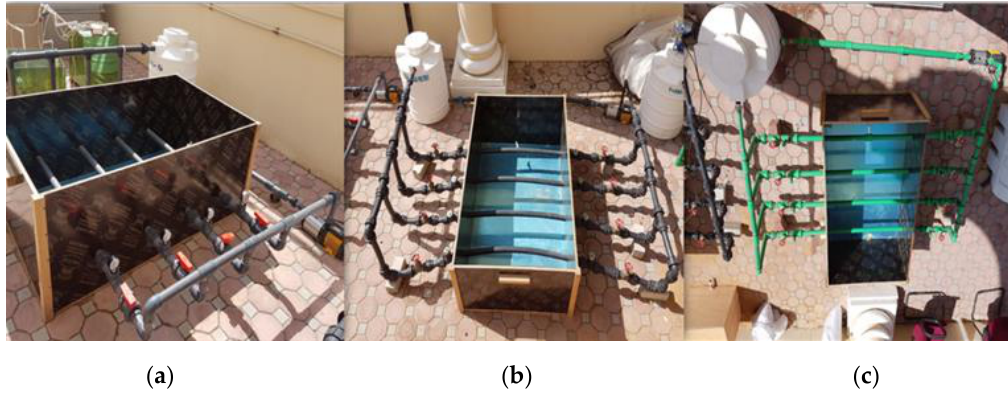
Figure 3. Setups with different types of pipe material: ( a ) PVC; ( b ) PE; and ( c ) PPR. Second, different types of leaks were induced to evaluate the ability of the NDTs on wide-ranging pipe conditions. The first pipe was undamaged, the second contained a vertical crack, the third had a hole, and last pipe consisted of a faulty joint as illustrated in Figure 4. To prevent water leaking from one pipe to seep to the adjacent pipes, the three simulated leaks were induced in different ends of the pipes. Thus, the vertical crack was induced on the left end of the second pipe (Figure 4a), the hole was drilled at the right end of the third pipe (Figure 4b), and the joint was installed at the center of the last pipe (Figure 4c).